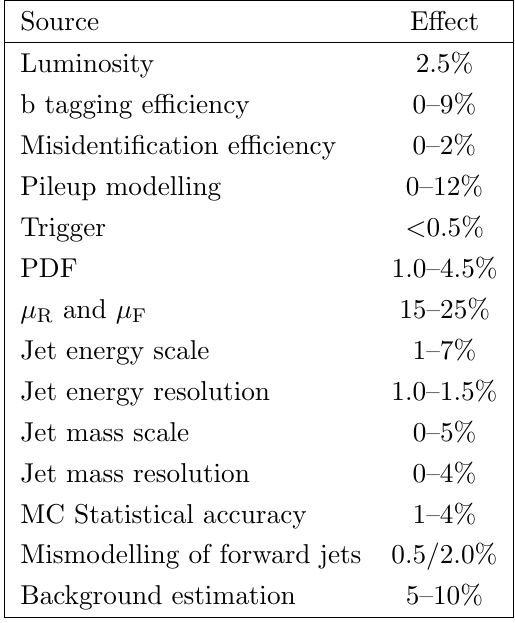
Table 3. Summary of systematic uncertainties in background events. The quanti(cid:12)cation of the e(cid:11)ects quoted in the table re(cid:13)ects the uncertainties in the event yields. All uncertainties are considered in the simulated background events, except the one on background estimation that a(cid:11)ects only the data-based estimate of the multijet process. All the systematic uncertainties apply to both categories of forward-jet multiplicity, except for the case of the modelling of the forward jets, where the (cid:12)rst entry corresponds to the category with no forward jets, and the second entry to the category with at least one jet in the forward